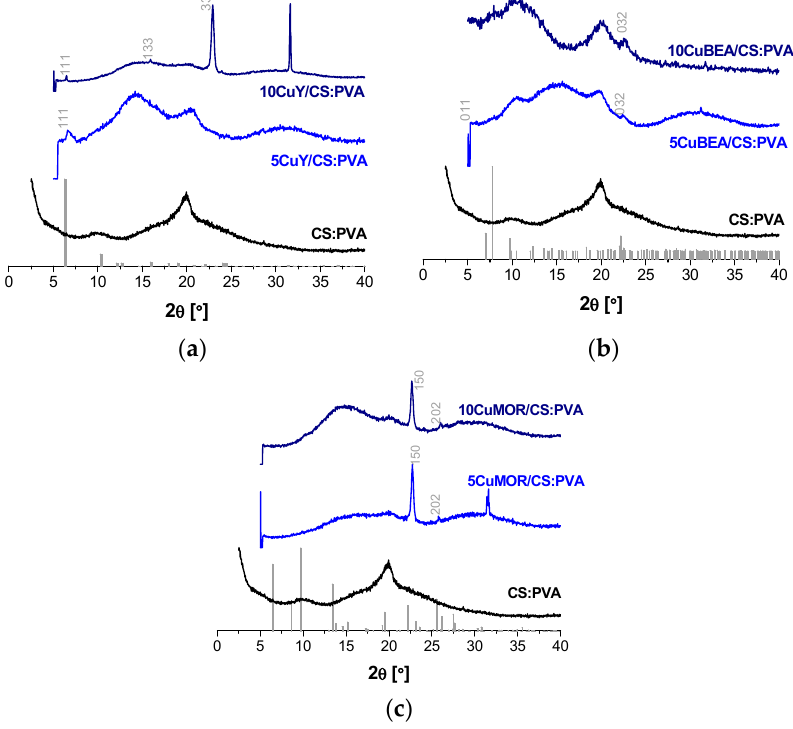
Figure 5. XRD diffractograms of CuY ( a ); CuBEA ( b ); and CuMOR ( c ) filled CS:PVA MMMs. The simulated patterns were taken from the crystallographic data of the International Zeolite Database (www.iza-structure.org/databases/).